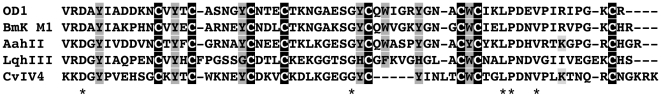
Comparison of CvIV4 with Old World α-toxins that modulate Nav1.7.CvIV4 is aligned with ODI, BmK MI, AahII and LqhIII, Old World α-toxins that slow the fast inactivation of Nav1.7. The biological activity of CvIV4 is similar to these peptides, but its primary structure is not. Gaps were introduced to align cysteine residues (white font with black background). Hydrophobic residues (dark shaded background) that are critical for α-toxin structure and function are conserved in CvIV4 at positions 5, 14, 22, 36, 43 and 49 [28]. CvIV4 shares a lysine (light shaded background) with AahII (position 60) that is critical for the biological activity of AahII [29]. Additional amino acids that are identical among toxins are marked with an asterisk (*). GenBank accession numbers: CvIV4 (JF938594), ODI (P84646), BmK MI (P45697), AahII (P01484), LqhII (P59355). MAFFT version 6 used for sequence alignment (http://mafft.cbrc.jp/alignment/software/).